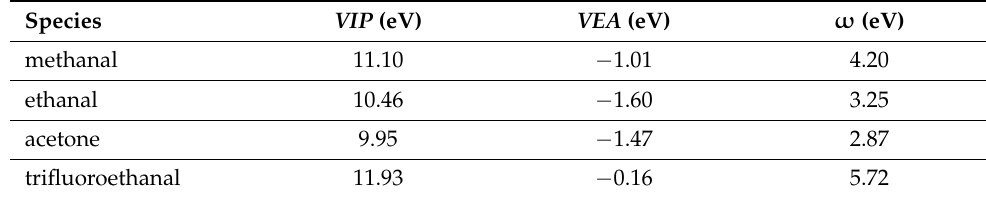
Table 4. Electrophilicities were calculated for different carbonyls.